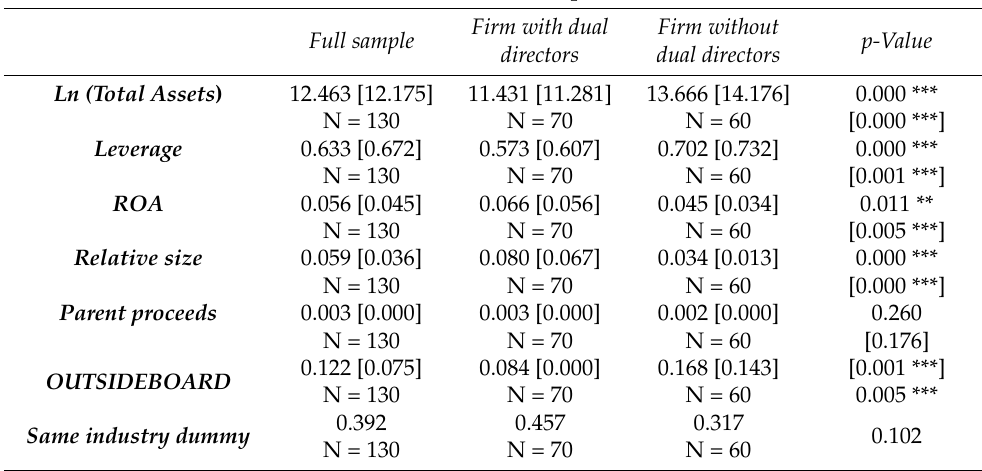
characteristics of carve-out subsidiary firms with dual directors and those without dual